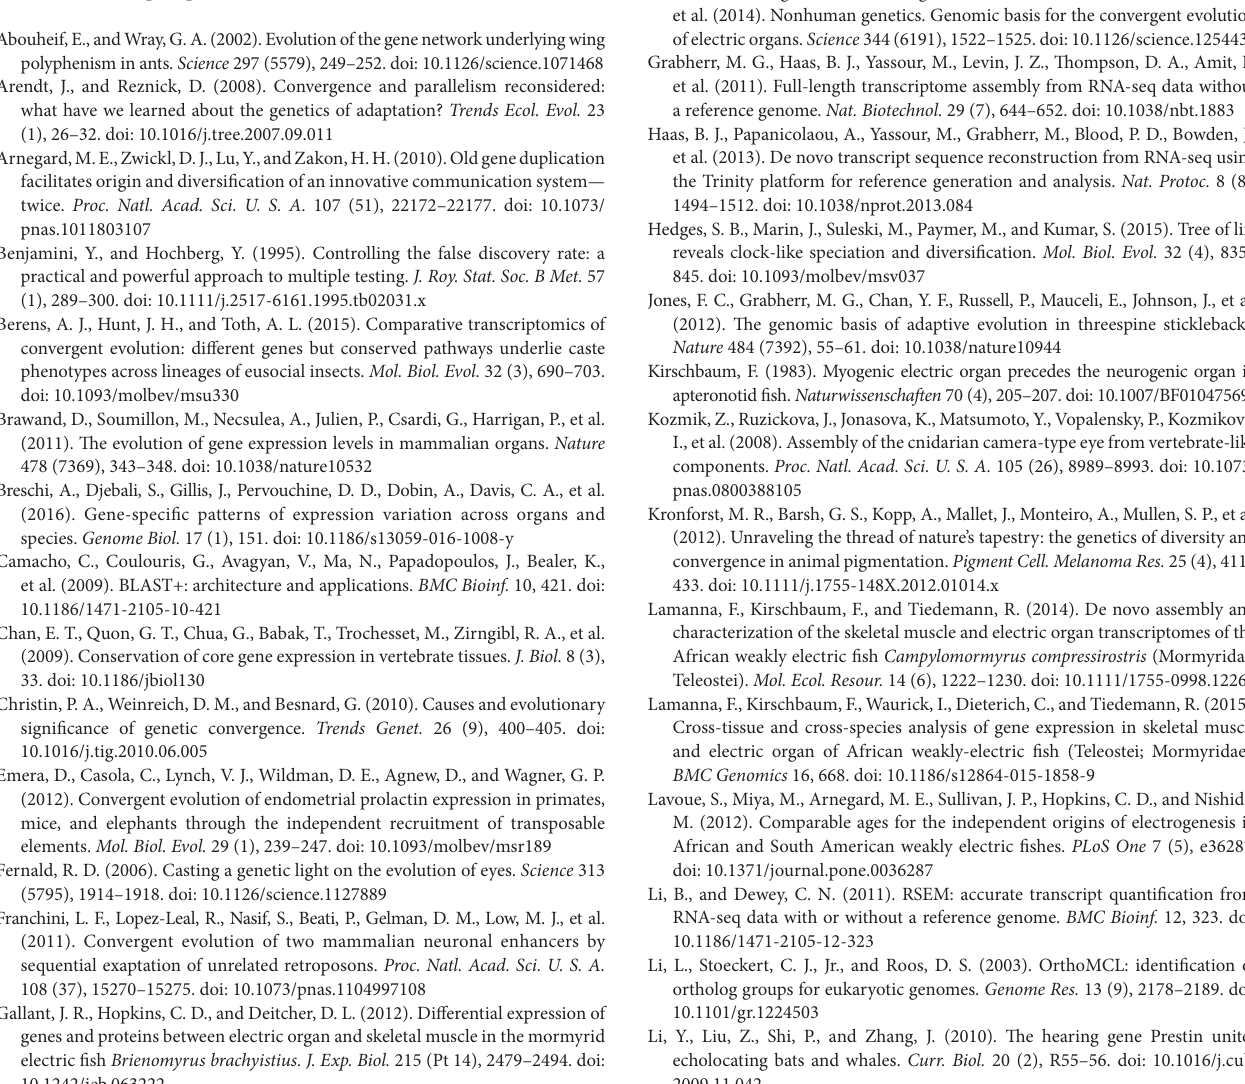
FIGURE S1 | The transcriptome assembly statistics assembled de novo with Trinity. FIGURE S2 | Phylogeny of gene expression based on different vector distances. A-D were constructed based on Pearson distance, Jaccard distance, Euclidean distance, and angular cosine distance, respectively. FIGURE S3 | Expression phylogeny of functionally related genes and the EOs and SMs. A. The NJ analysis based on 696 functionally associated genes. The NJ trees of gene expression phylogenies for the SM (B) and the EO (C). The tree topologies were calculated based on pairwise distance matrices (1- ρ ). FIGURE S4 | Co-expression and clustering of the EO and SM in electric fish. The gene number of each gene cluster is shown in the lower left corner. The white polyline represents the median centralized expression value of a single gene log2 in each sample, and the red polyline represents the median value of the gene cluster in different samples. The background colors of blue, green, and red represent three species of Mormyroidea, Siluriformes, and Gymnotiformes, respectively. The left part is the SM, and the right part is the EO.